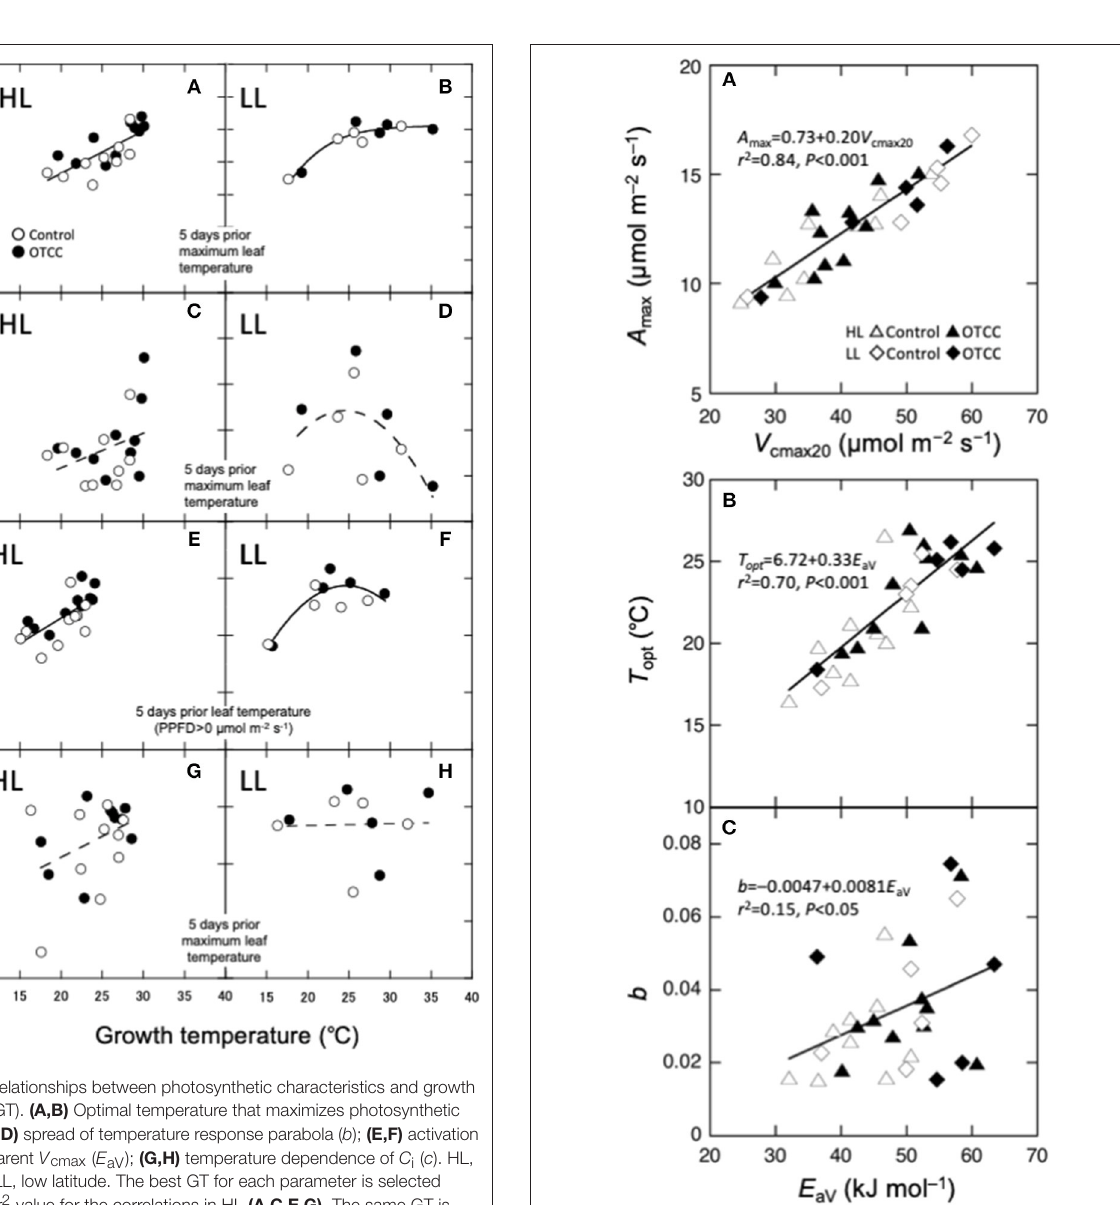
environmental cue that brings about such variation.